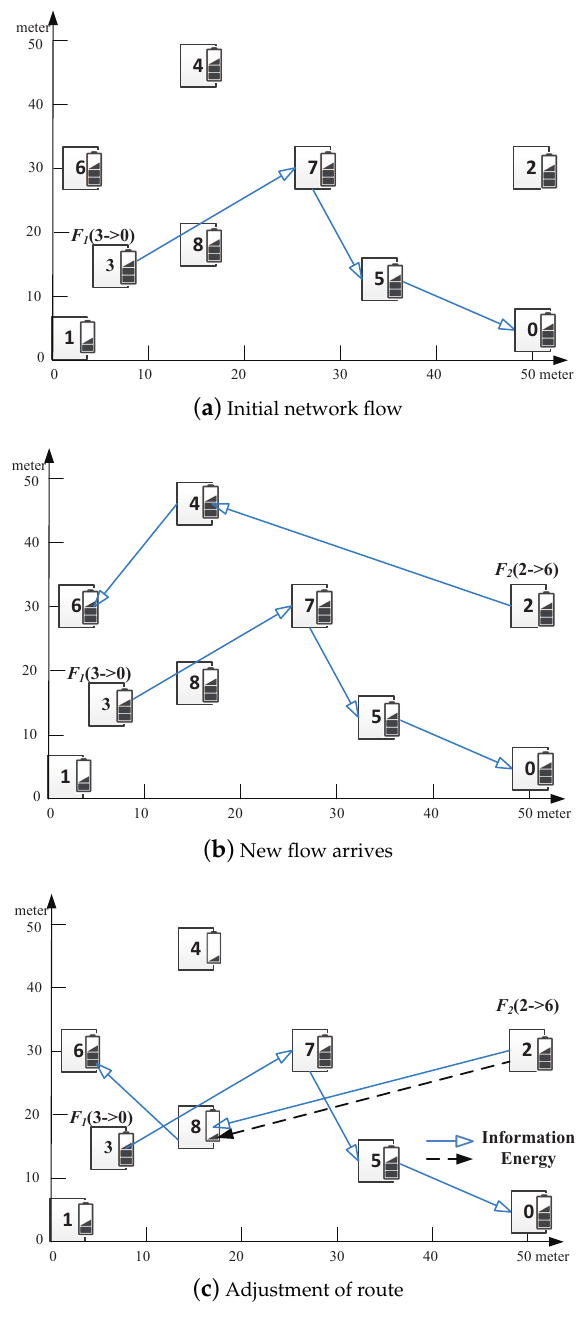
Figure 5. Motivation examples. ( a ) there exists a flow F 1 from node 3 to node 0 with the